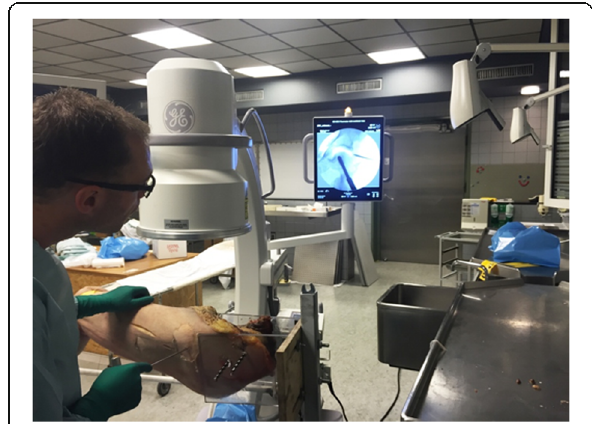
Fig. 3 Images of the surgical setup during ACH. The lateral portal was placed using fluoroscopic guidance